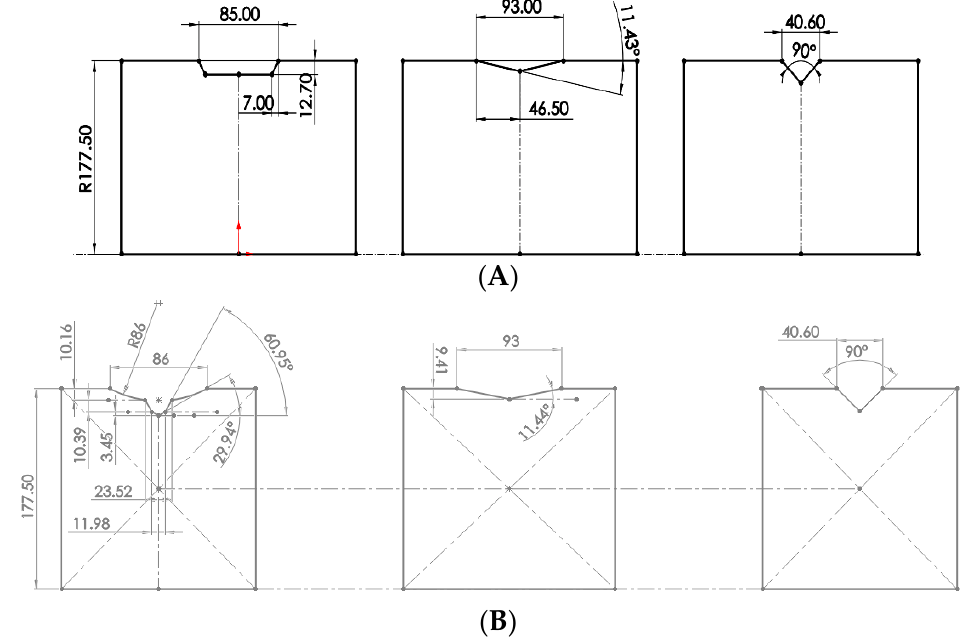
Figure 4. Roll dimensions (in mm). ( A ) Bottom roll dimensions (in mm). ( B ) Top roll dimensions (in mm).